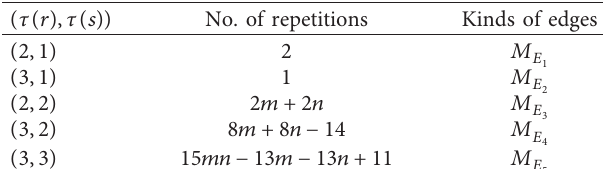
Table 5: Edge partition of Si of end vertices.